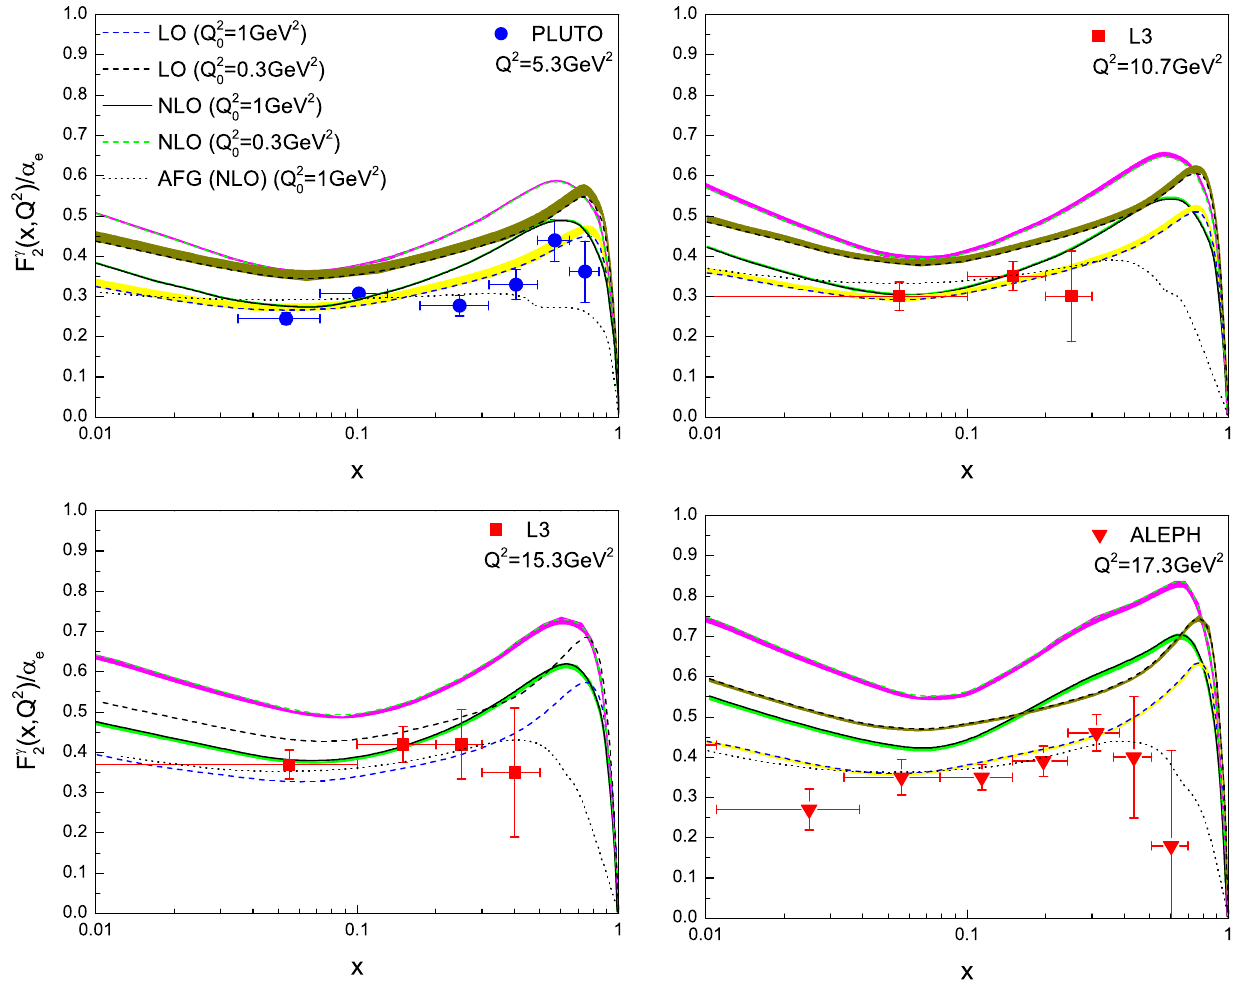
γ at different initial scales Q 2 2 = 1GeV 2 in 0